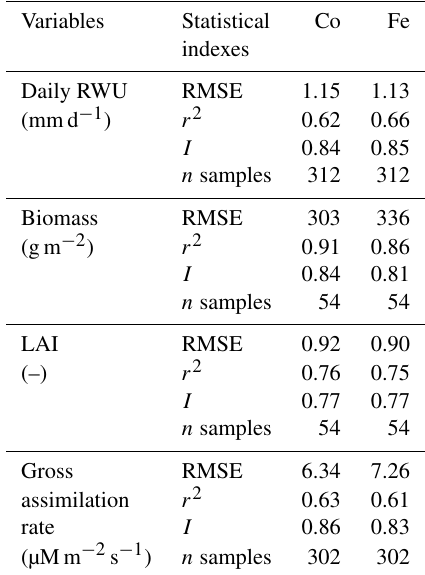
Table 1. Quantitative and statistical measures of the comparison between two modeling approaches and the observed data for the three water treatments and two soil types. RMSE is the root mean square error; r 2 is the correlation coefficient; I is the agreement in- dex; n samples is the number of samples. Co is the Couvreur RWU model, and Fe is the Feddes RWU